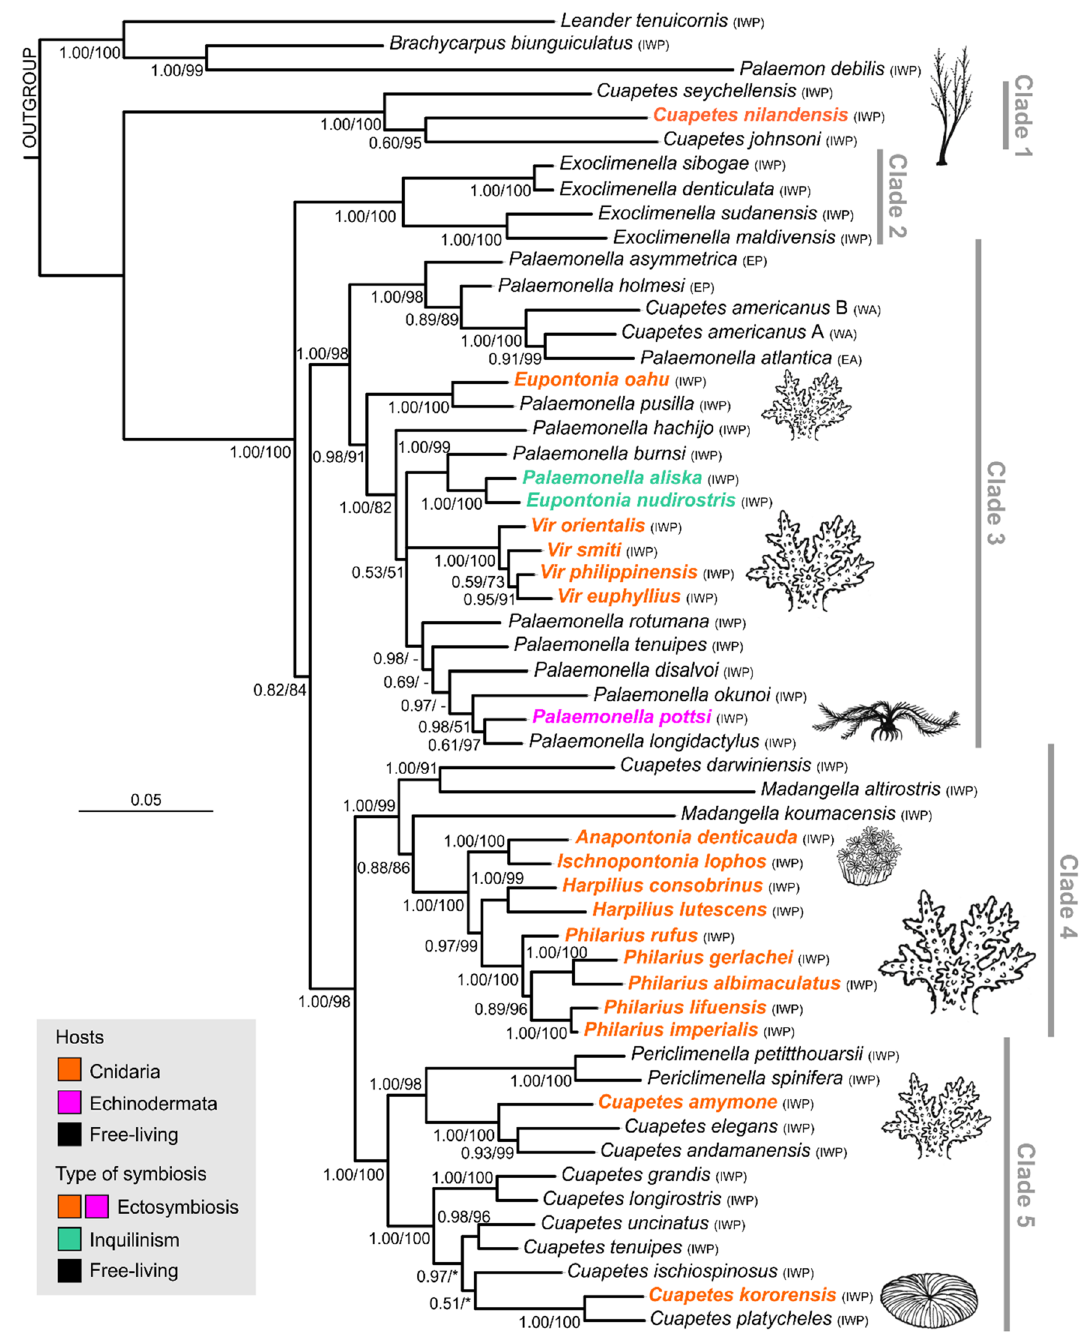
Figure 2. Phylogenetic tree of symbiotic shrimp taxa resolved by Bayesian inference based on the combined dataset for six genes (COI, 16S, H3, 18S, Enol, NaK). Ultrafast bootstrap (UFB) support is expressed as a percentage. Dash (–) indicates UFB values < 50; asterisk (*) indicates different topology of Maximum Likelihood tree. Major clades and host affiliations are highlighted. Abbreviations of areas: IWP Indo-West Pacific, EP eastern Pacific, WA western Atlantic, EA eastern